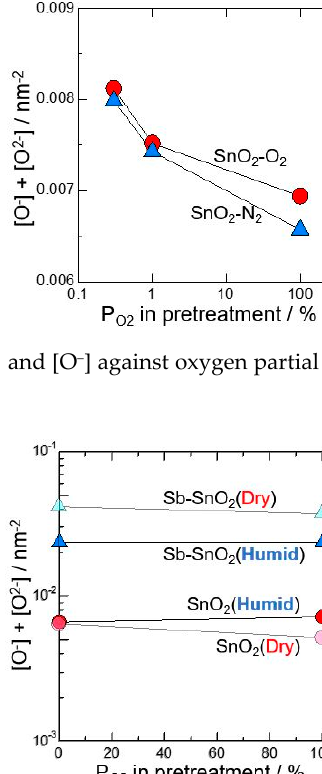
Figure 1. Relationship between amount of oxygen adsorption species and oxygen partial pressure in pretreatment (measured in dry atmosphere).